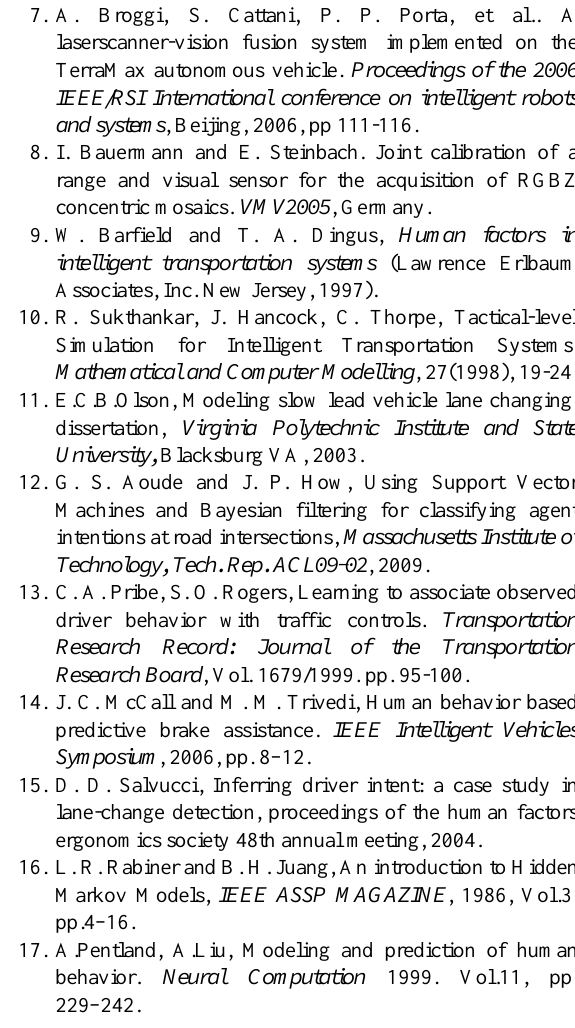
Fig. 2. Examples of parameters during a lane change